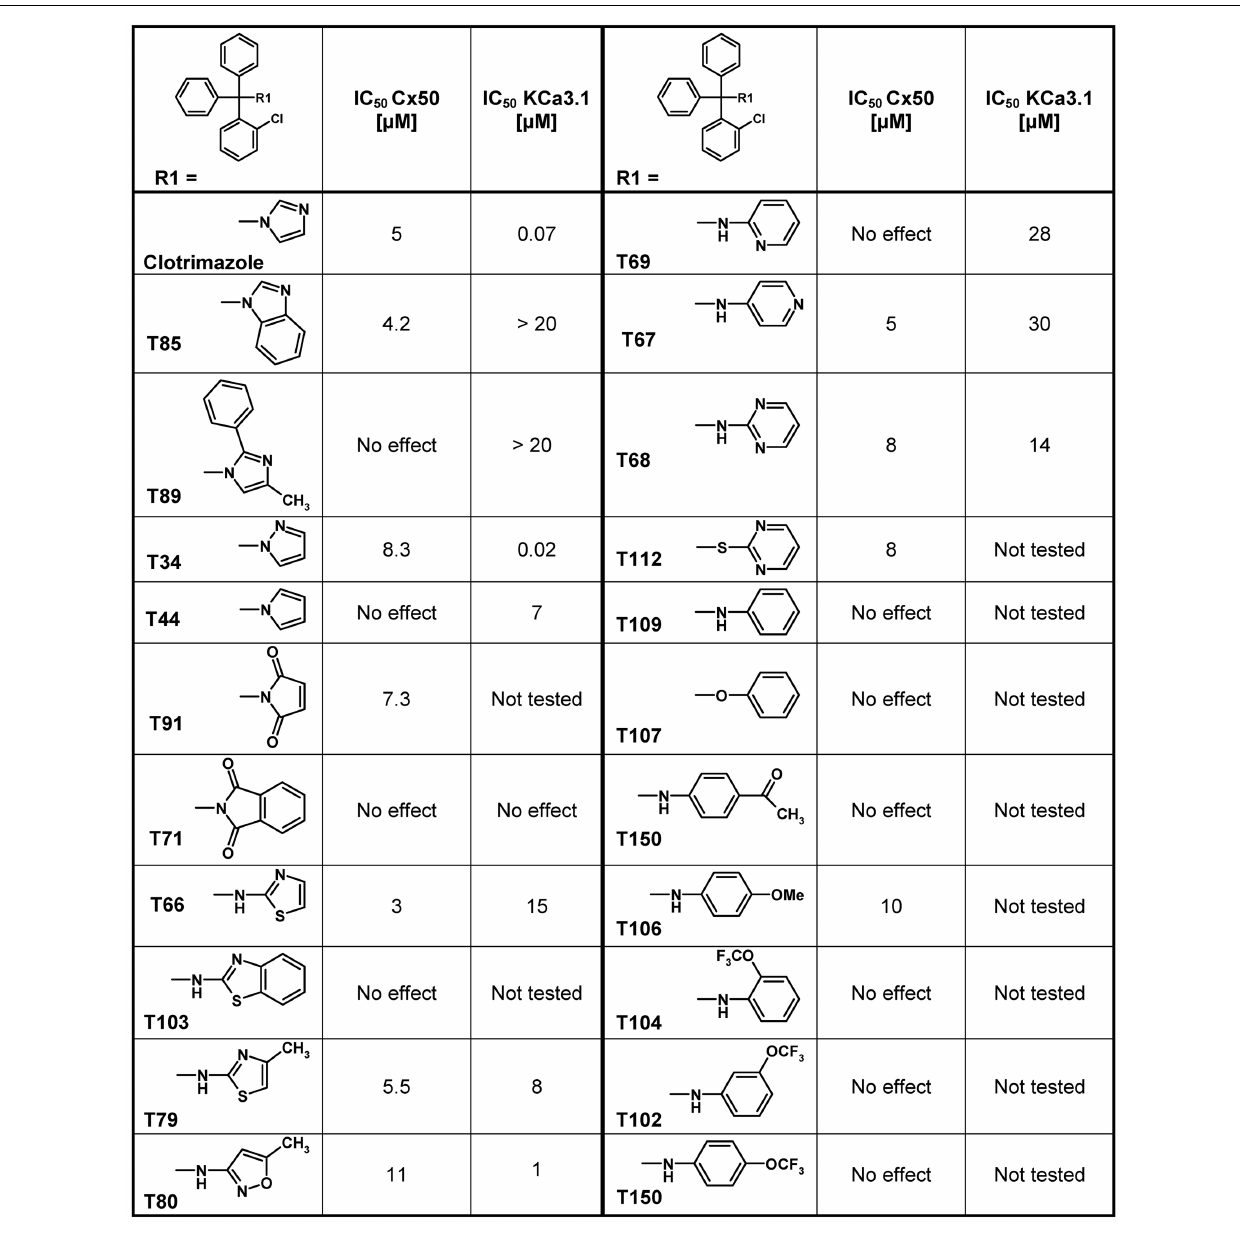
the methods. Means of current inhibition and SD were determined by application of two or three concentrations of each triarylmethane to multiple cells ( n ranging from 3 to 8 per concentration).The SD values are not shown for clarity; SD values typically ranged between 5 and